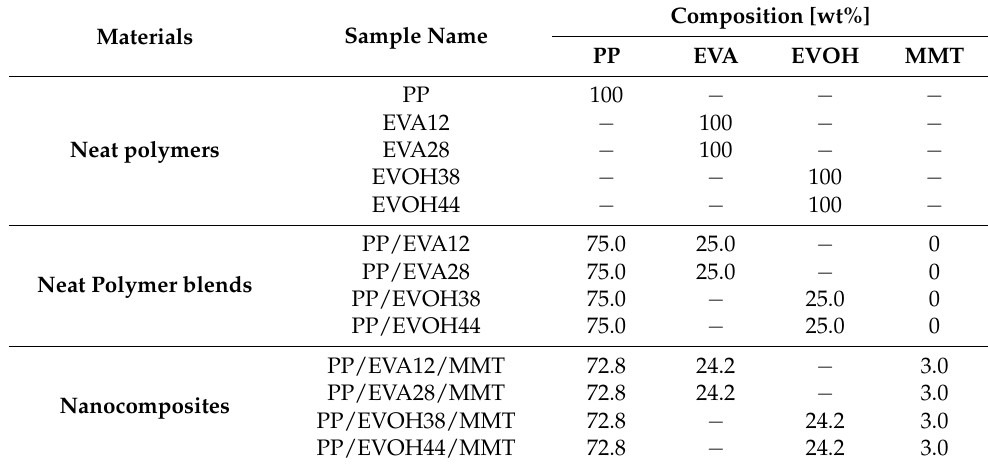
Table 1. Composition in wt% of the samples